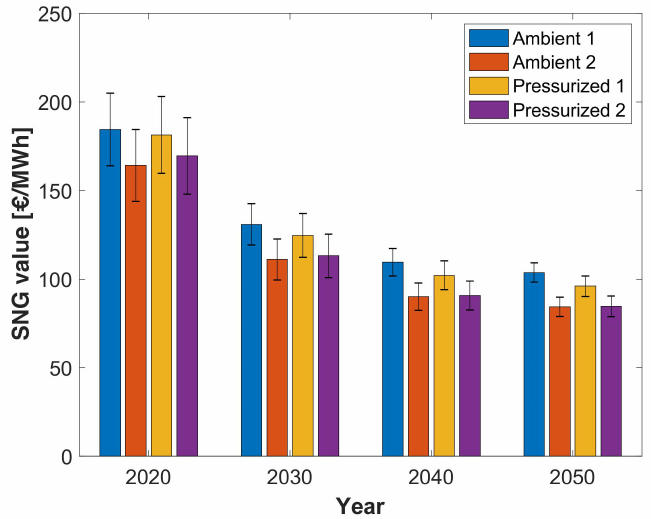
Figure 12. SNG value as a function of the SOEC cost development up to 2050: the bar plot refers to SOEC cost of medium size, while the upper and lower limits of the error bar refer to SOEC costs of a small and large size,